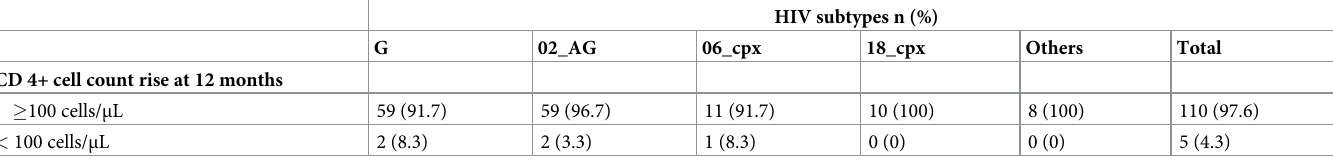
Table 2. Proportion with favorable immunologic response (CD4+ cell count rise of � 100 copies/ μ L from baseline) at 12 months after initiation of ARV